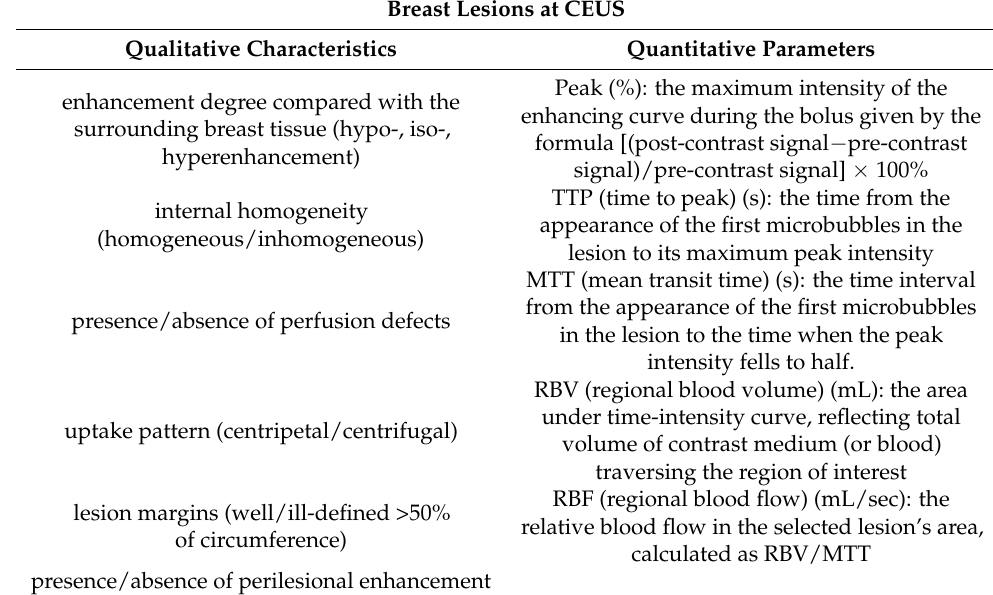
Table 1. Qualitative characteristics and quantitative parameters of breast lesions at CEUS [1,4]. Breast Lesions at CEUS